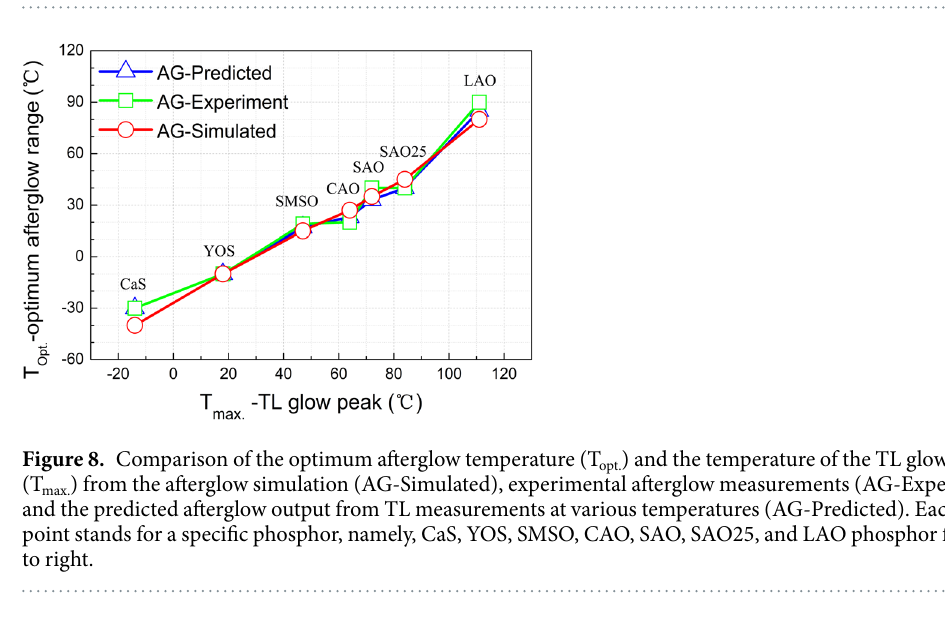
Figure 7. ( a ) TL glow curve of CAO phosphor and its corresponding fitting curve. ( b ) Prediction of afterglow profile of CAO phosphor at different temperatures.